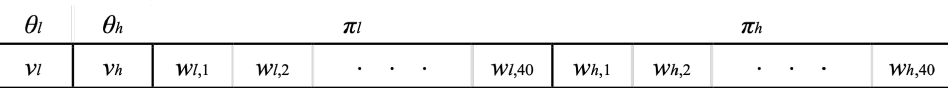
Figure 4. Representation of candidate